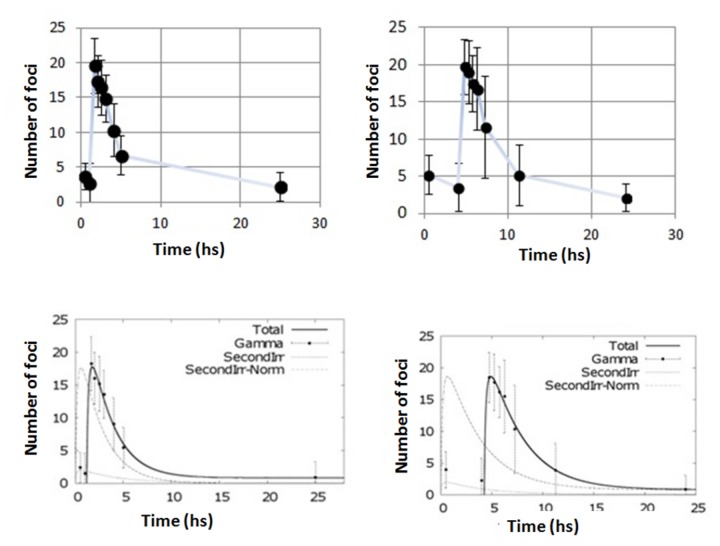
Split dose irradiations with small initial dose.Number of γ-H2AX foci after exposure to 0.1 Gy at time 0 plus 1 Gy delivered 1 hr after (left column) and 4 hr later (right column). Top panels report the experimental data;bottom panels, data are fitted using the modelling equation (4). In the bottom panels, the solid line represents the modelling function for the split dose scenario. The dotted lines represent the modelling function for the individual radiation exposures. Error bars represent the standard error of the mean of 3 independent experiments.